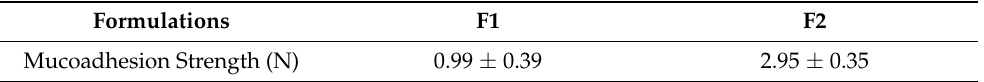
Table 8. Mucoadhesion strength of PLX- (F1) and TPLX- (F2) based compressed tablets.